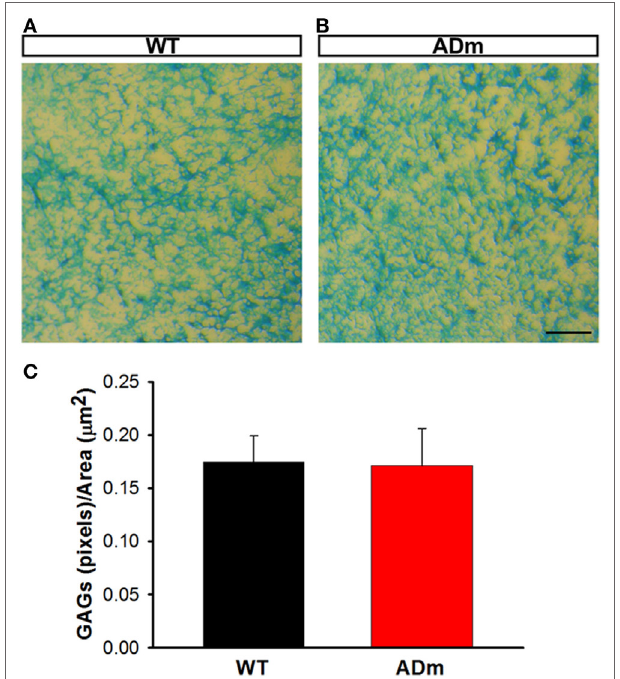
FigUre 5 | Cortical laminin staining. Cortical cryosections from WT mice (a) and ADm mice (B) subjected to RA exposures were stained with anti-laminin antibody. Scale bar 200 µm. (c) Quantification of the green pixels (laminin) per area ( μ m 2 ) in WT tissue (black bar) and in ADm tissue (red bar) using Image J software. Using t -test analysis no statistical differences between the two groups, WT vs. ADm, were found. Data are presented as mean ± SE. WT, wild type; ADm, Alzheimer’s disease transgenic mouse; RA, room